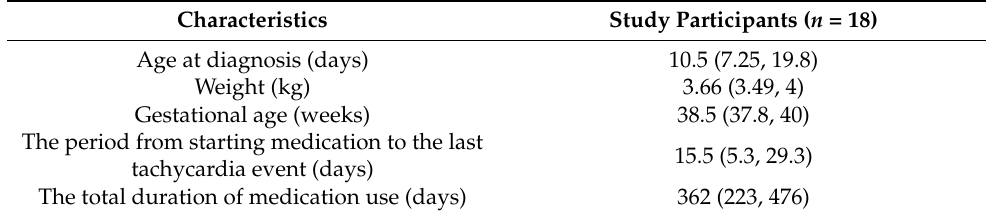
Table 1. Patient characteristics (continuous variables).